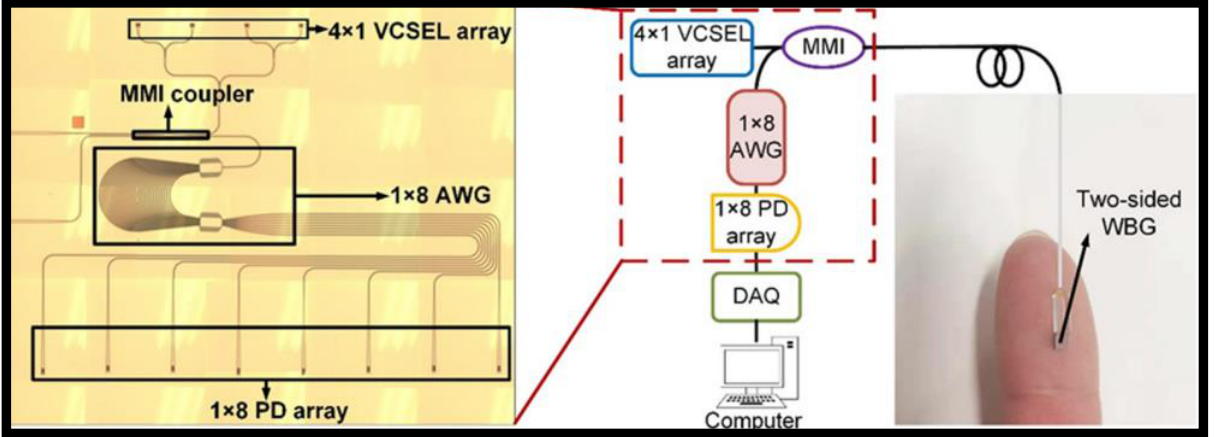
Figure 5. The layout and principle of the PIC of an AWG interrogation system [70],.